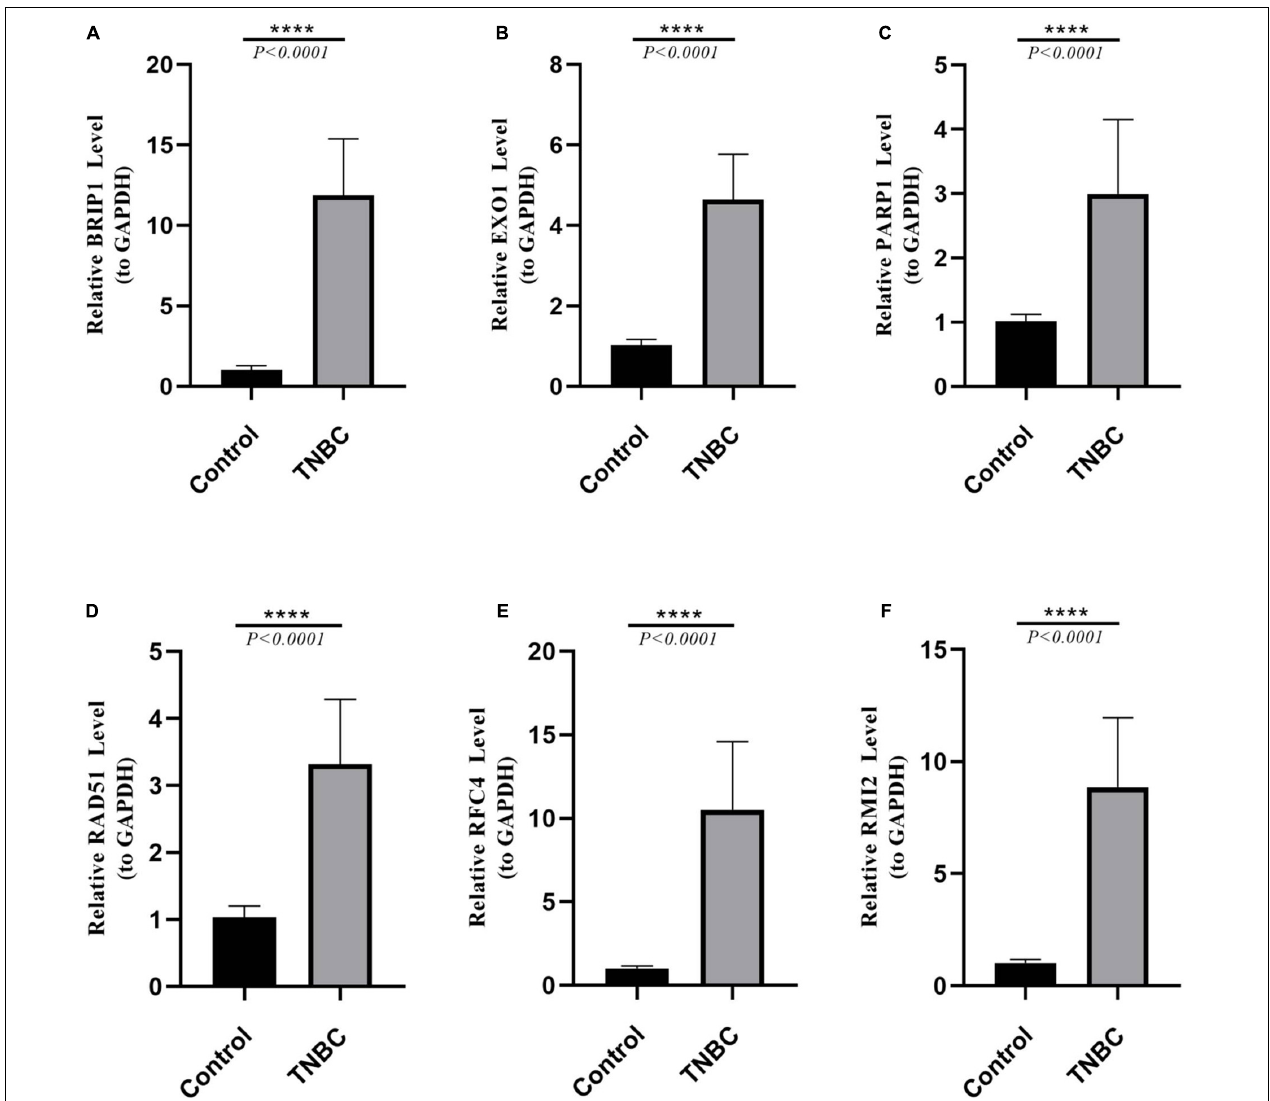
FIGURE 3 | Results of quantitative real-time PCR (qRT-PCR) validation of six differentially expressed genes (DEGs) in TNBC tumor tissues (TNBC) and adjacent normal tissues. The expression of each of these six DEGs was significantly increased in tumor tissues ( P < 0.0001). Expression levels measured by qRT-PCR analysis of (A) PARP1 . (B) RAD51 . (C) EXO1 . (D) BRIP1 . (E) RMI2 . (F) RFC4